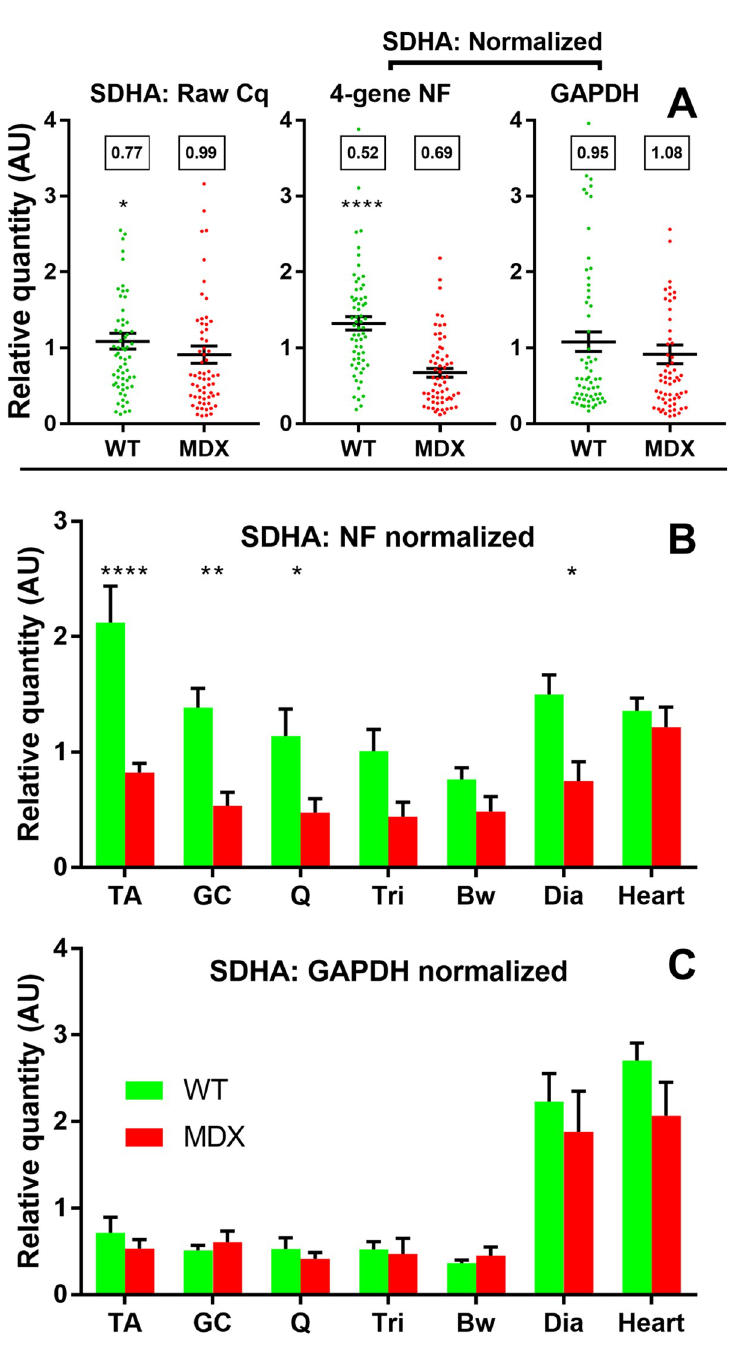
Fig 5. Succinate dehydrogenase subunit A expression. (A) Expression data for SDHA in all healthy and dystrophic samples, either raw relative quantity (RQ) values (left); normalized to the geometric mean of ACTB , RPL13a , CSNK2A2 and AP3D1 (centre); or to GAPDH (right). (B) and (C) expression data for SDHA in healthy and dystrophic samples sorted by muscle group (as indicated) normalized to the geometric mean of ACTB , RPL13a , CSNK2A2 and AP3D1 (B) or to GAPDH (C) . Data shown either as individual sample RQ values (•) and means +/- SEM, or means + SEM alone. � :P < 0.05; �� :P < 0.01, ���� :P < 0.0001 (Mann-Whitney U test (healthy/dystrophic) or one-way ANOVA with Sidak’s multiple comparisons test (healthy/dystrophic by muscle)). Boxes: Coefficient of Variation.